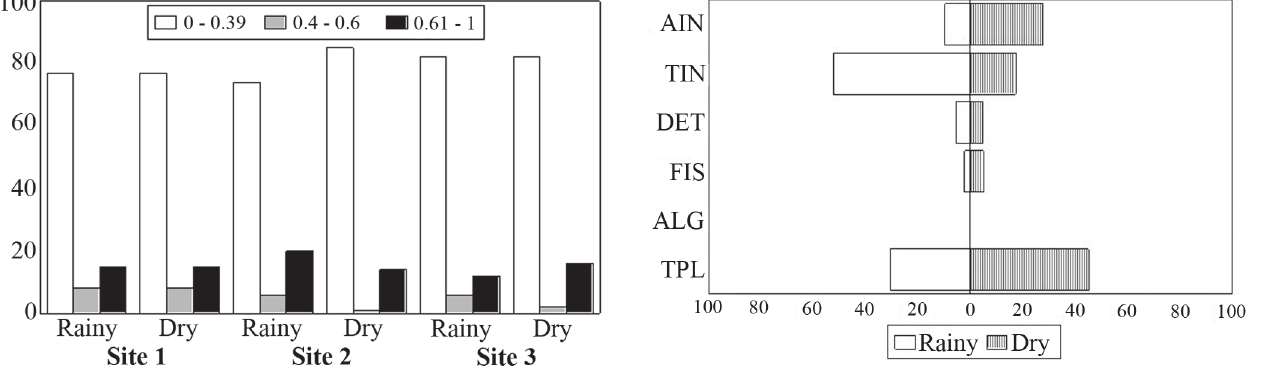
Fig. 4. Percentage composition of food resources consumed by fish species of Itiz stream, Ivaí River basin, Paraná State, Brazil, at site 1 in each hydrological period. AIN = aquatic invertebrates; TIN = terrestrial invertebrates; DET = detritus; FIS = fish; ALG = algae; TPL = terrestrial